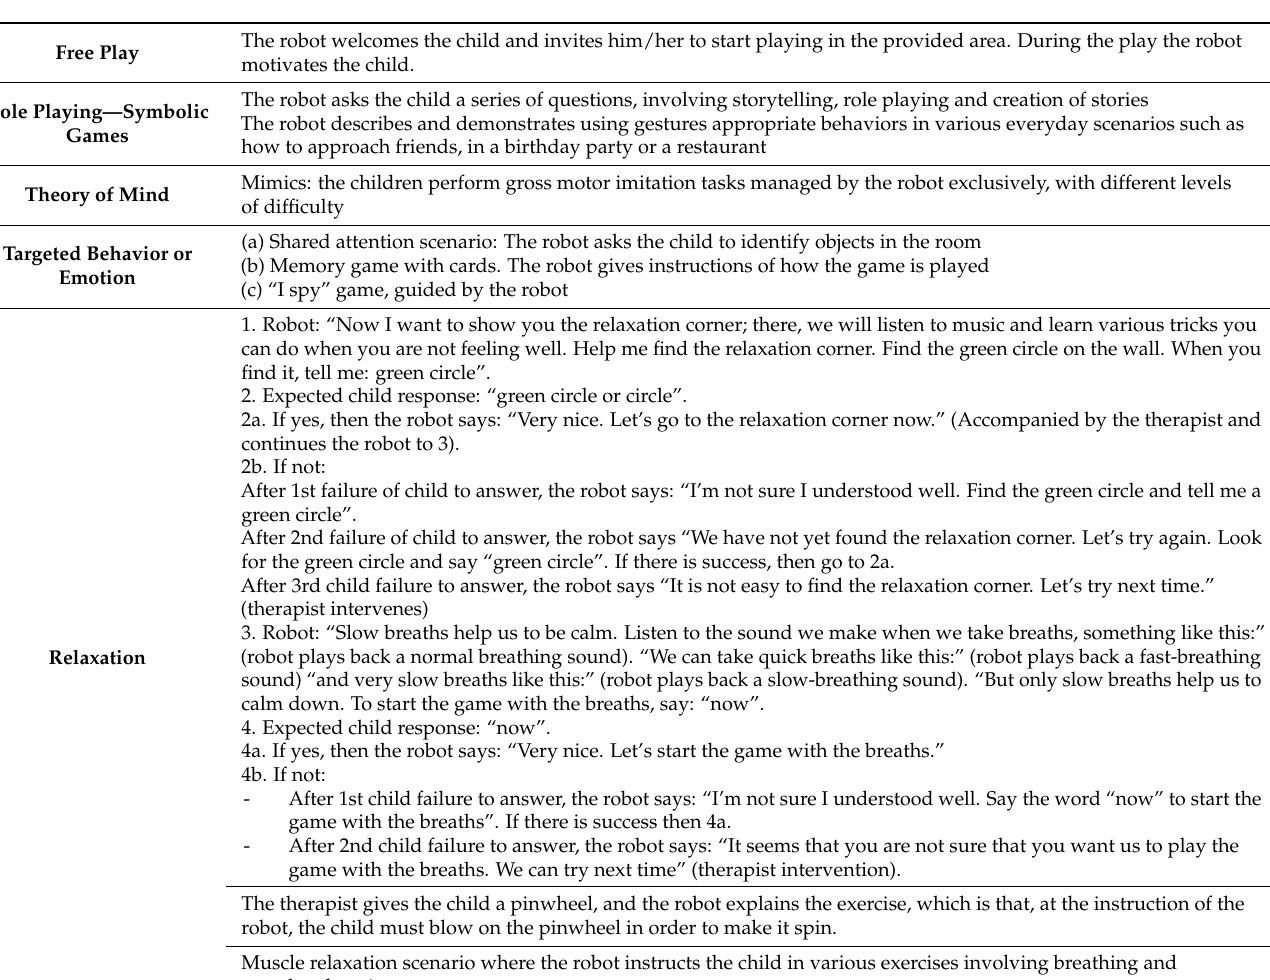
Table A1. Activities considered in the behavioral